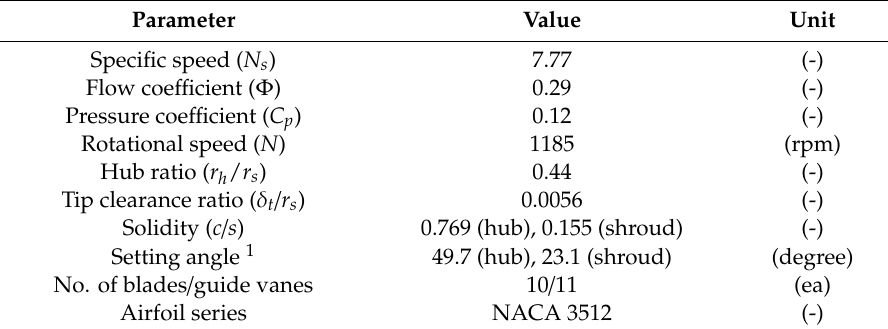
Figure 2. Axial fan unit: ( a ) three-dimensional (3D) view; ( b ) front view; ( c ) side view. Table 1. Design specifications and parameters of the reference axial